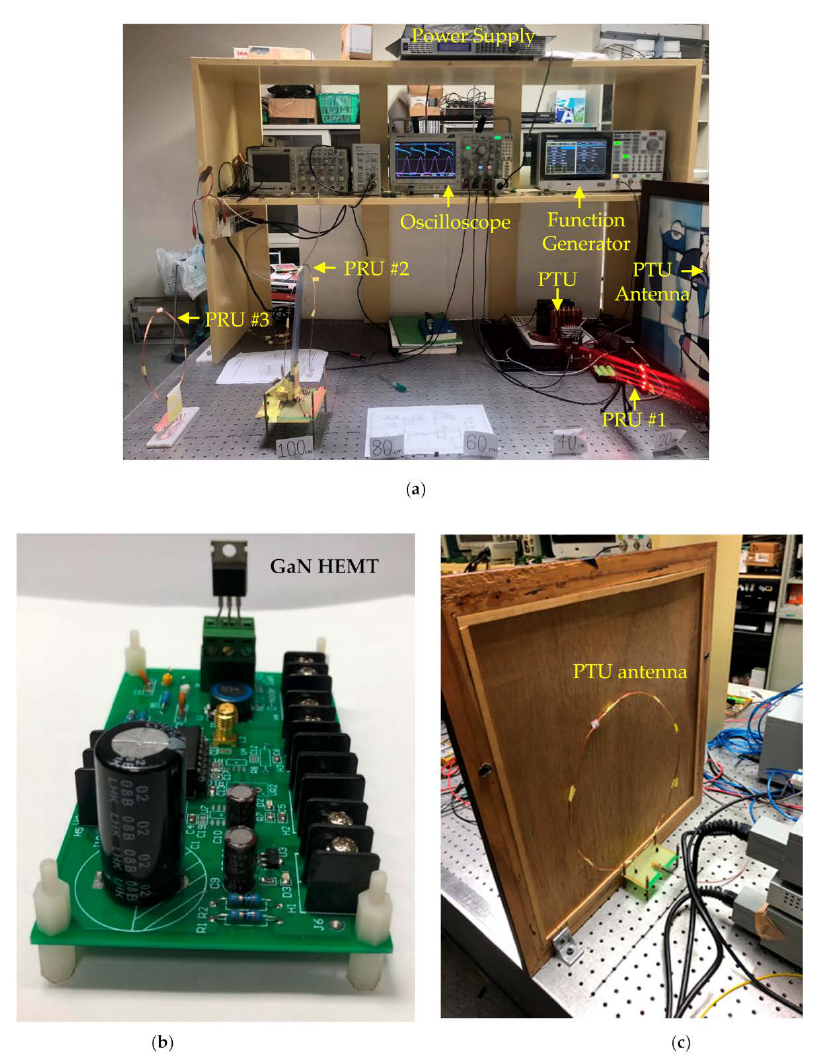
Figure 15. Live example of WPT to multiple PRUs. ( a ) Experiment setup with a single PTU transfer- ring power to multiple PRUs. The PTU antenna is hidden behind the painting. The layout is shown in Figure 15; ( b ) the close picture of class-E PA, and ( c ) the close picture of PTU